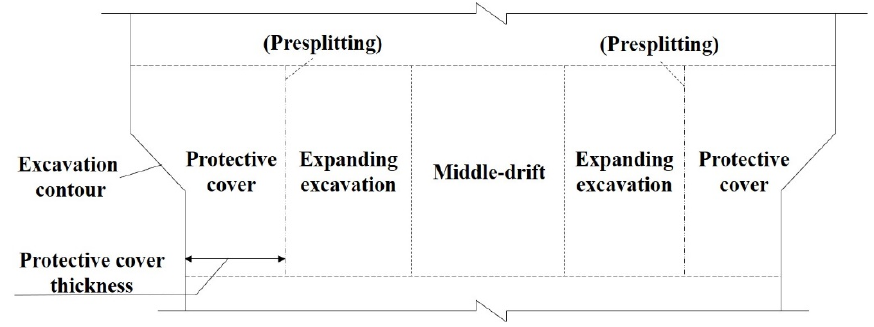
Figure 13. MEP and MEP(P) methods of the rock anchor beam zone.